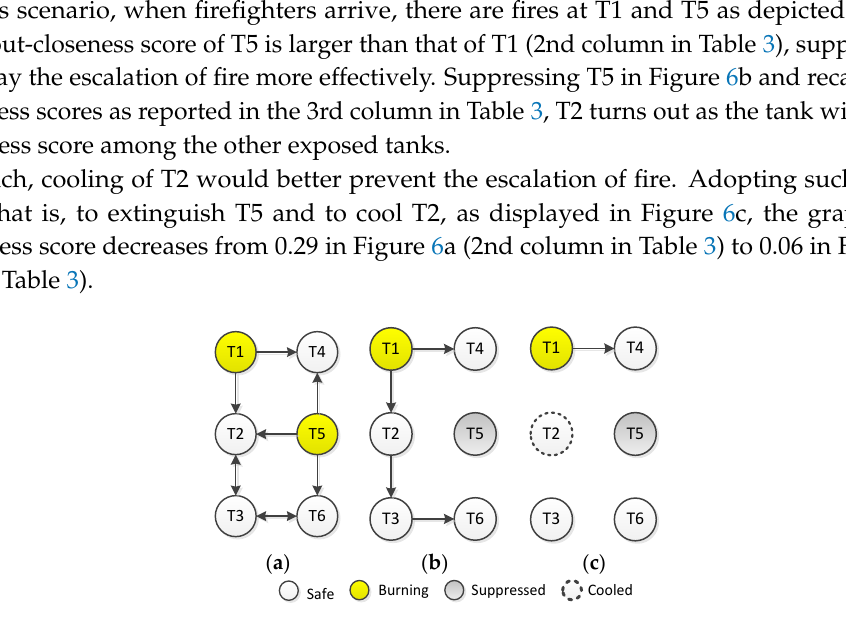
out-closeness score of the plant are depicted with bold numbers in Table 3.